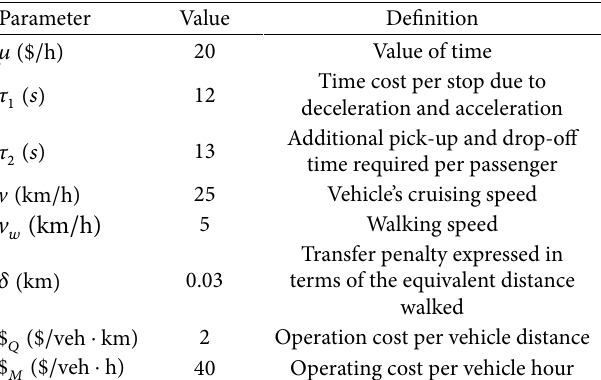
Figure 2: Trajectory of the flexible vehicle. Table 1: Important notations and default